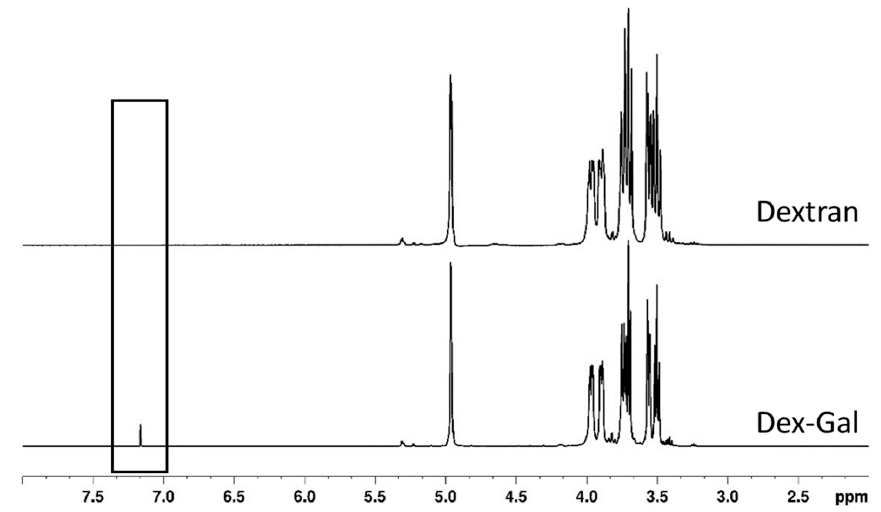
Figure 3. Dextran and Dex–Gal 1 H-NMR spectra. The signal at 7.16 ppm is highlighted.